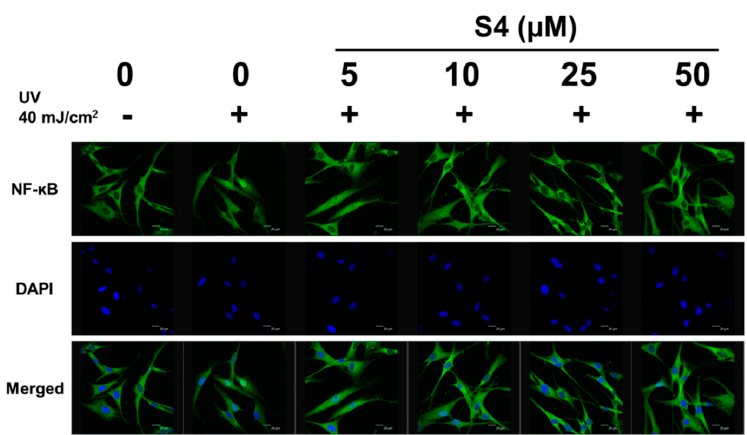
Figure 8. Effect of S4 on UVB-induced activation of nuclear factor kappa-B p65 in human skin fibroblasts.